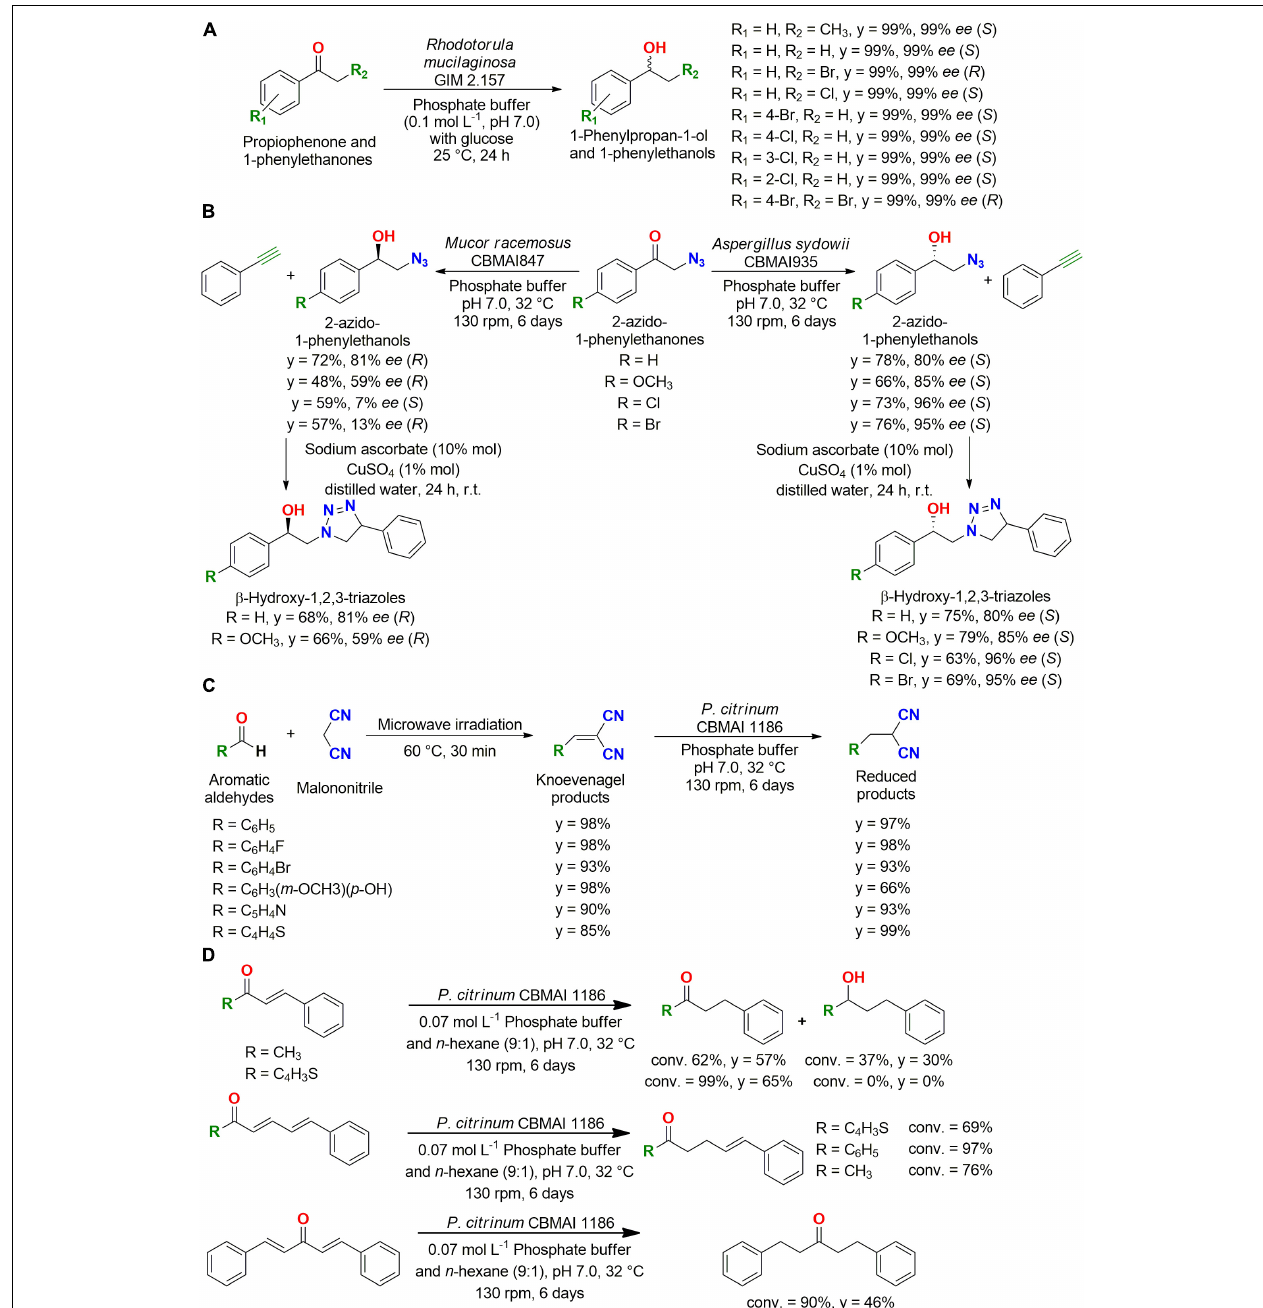
FIGURE 4 | (A) Reduction of 1-phenylpropan-1-one and 1-phenylethanones to 1-phenylpropan-1-ol and 1-phenylethanols by Rhodotorula mucilaginosa GIM 2.157 (Liu et al., 2018b). (B) Enantiocomplementary synthesis of β -hydroxy-1,2,3-triazoles employing marine-derived fungi as biocatalysts (Alvarenga and Porto, 2017). (C) Reduction of double bonds of Knoevenagel condensation adducts by P. citrinum CBMAI 1186 (Jimenez et al., 2016). (D) Reduction of C – C double bonds of α , β -, di- α , β -, and mono- α , β , γ , δ -unsaturated ketones by P. citrinum CBMAI 1186 (Ferreira et al., 2015b).